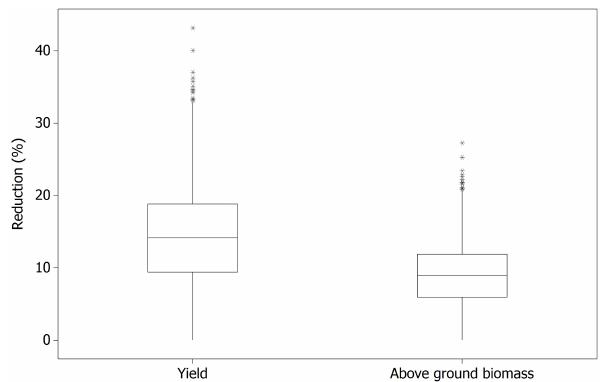
Figure 5. Estimated relative grain yield and above-ground biomass loss of wheat in Europe. The box and whisker plots are based on calculations of POD 6 for all (ca. 50 × 50km 2 ) grid squares from the EMEP MSC-W model in which wheat is grown. The box represents the 25–75% range of the data, whiskers show the full range of the data, and ∗ indicates